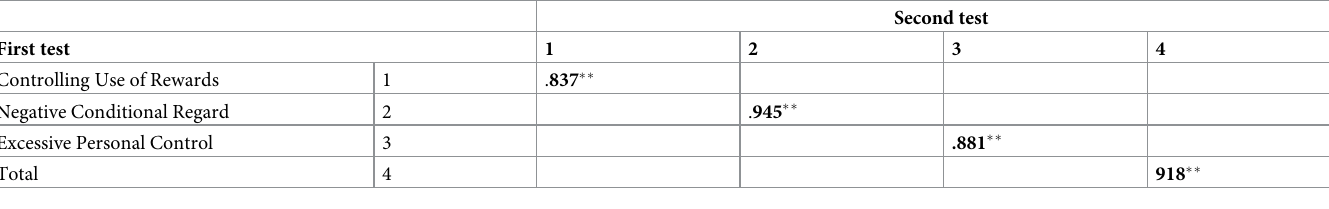
Table 3–1. The test-retest reliability of Controlling Coach Behaviors